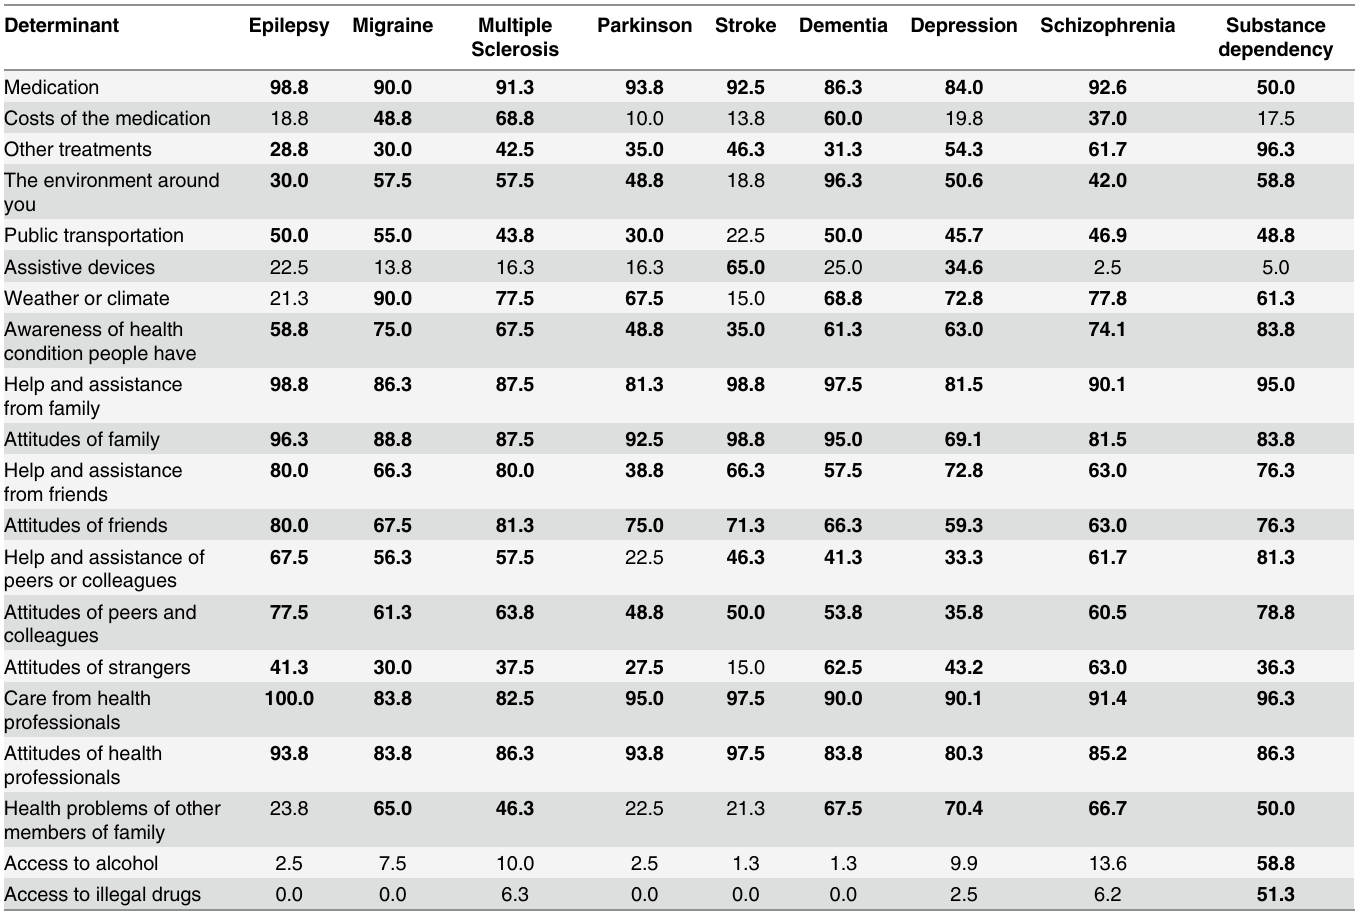
Table 3. Environmental determinants included in the data collection protocol and the percentage of persons who experienced them as having a positive or negative influence in their psychosocial